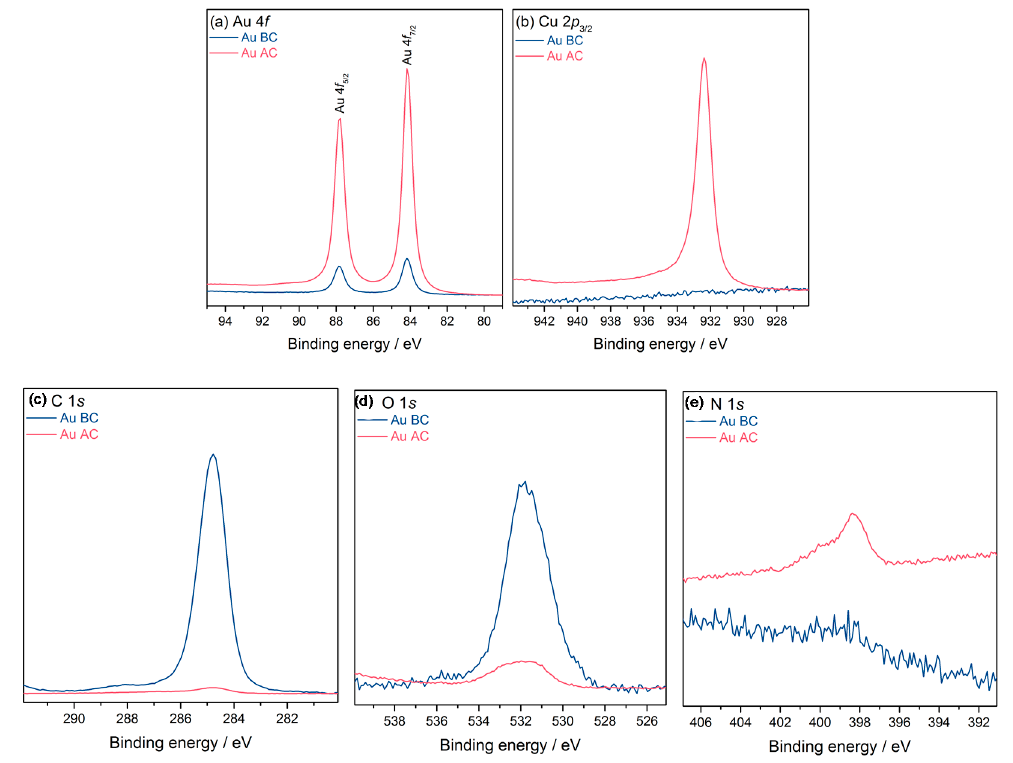
Figure 2. XPS spectra ( a ) Au 4f, ( b ) Cu 2p3/2, ( c ) C 1s, ( d ) O 1s, and ( e ) N 1s regions obtained before and after cleaning process of gold-plated PCB